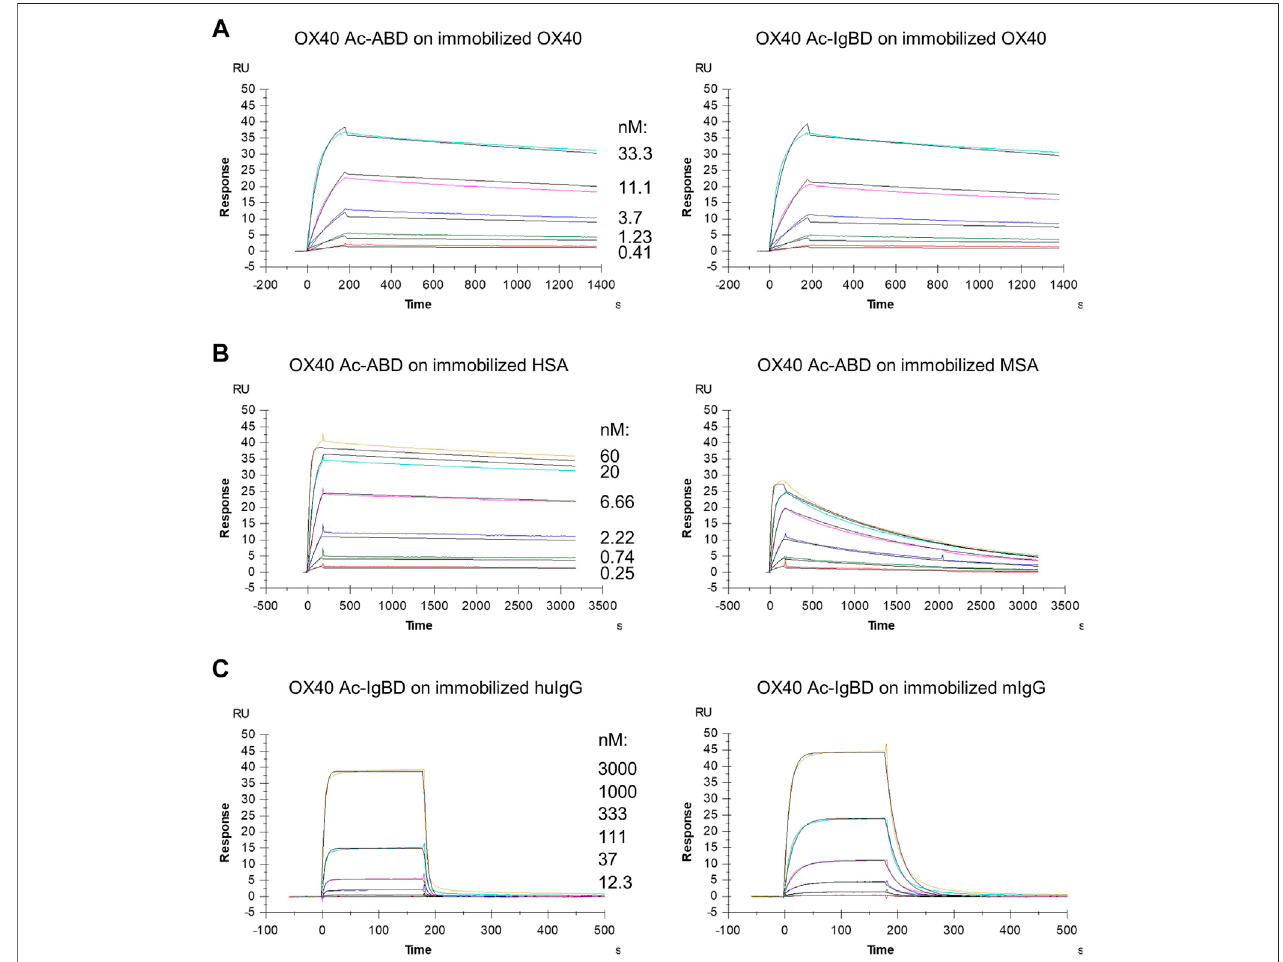
FIGURE 2 | Binding of Anticalin fusion proteins to OX40 receptor and serum proteins in SPR. The sensorgrams show the binding kinetics of exemplary OX40 Ac- ABDandOX40Ac-IgBDanalytesappliedinserialdilutionstotheimmobilizedOX40receptororserumproteinligands.Blacklinesrepresenta1:1model fi t. (A) OX40Ac- ABD (left) andOX40 Ac-IgBD (right) wereanalyzed forbindingtorecombinanthuOX40-His coupledtoaCM5 sensorchip. (B) OX40 Ac-ABD wasanalyzedforbinding to biotinylated HSA (left) and biotinylated MSA (right) ligands immobilized on a CAP sensor chip. (C) OX40 Ac-IgBD was analyzed for binding to biotinylated trastuzumab (left) and biotinylated mouse IgG (right) ligands immobilized on a CAP sensor chip.